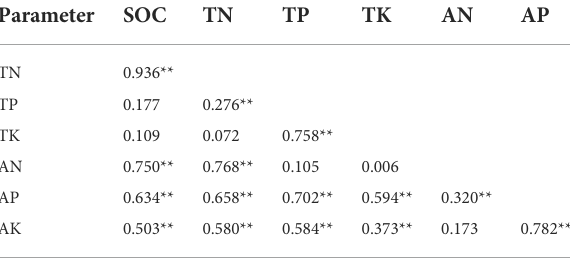
TABLE 3 Correlation coef fi cients between soil